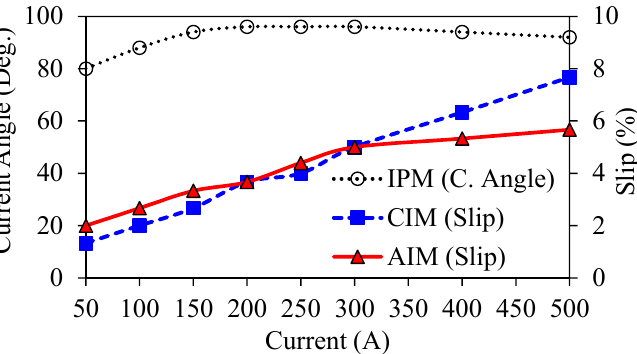
Figure 8. Variation of current angle (for IPM machine) and slip percentage (for IMs) with respect to peak current.